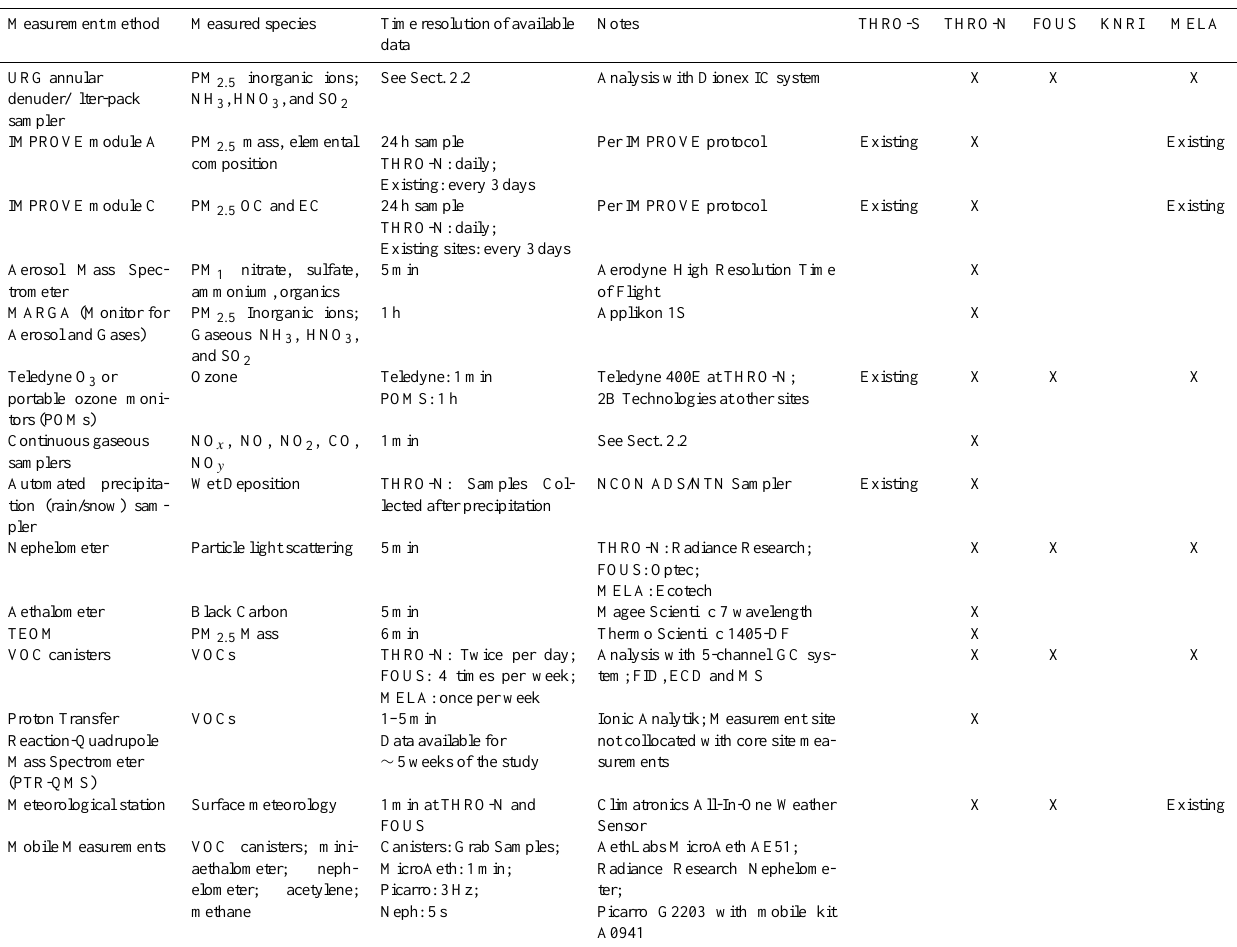
Table 2. Measurements from the second field campaign: 23 November 2013–28 March